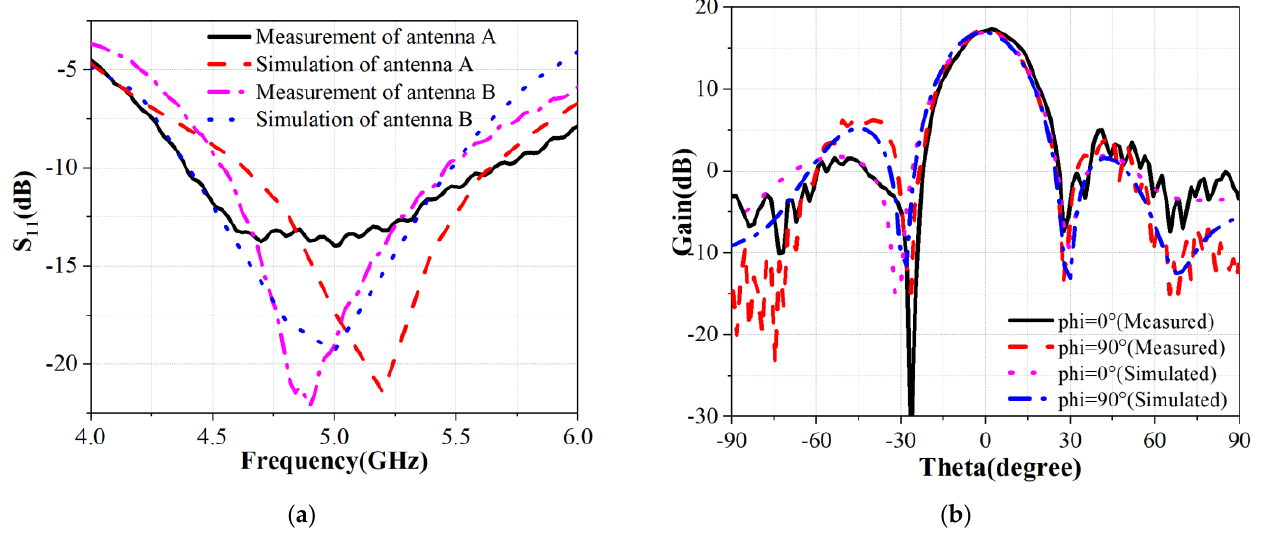
Figure 23. Measured and simulated radiation performances of the proposed patch array antenna. ( a ) S 11 ; ( b ) far−field